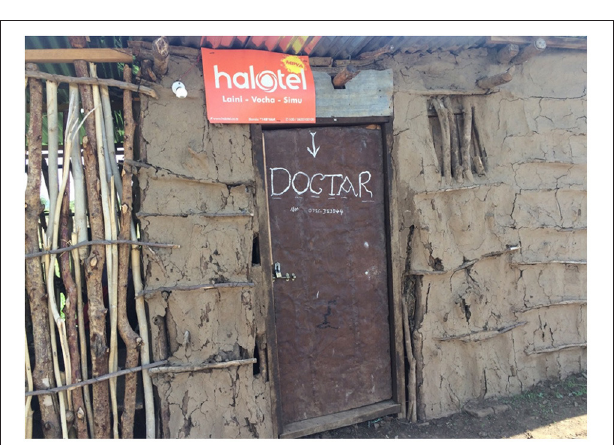
FIGURE 3 | A basic shop or “duka” in Naiti village where locals obtain most of their medicines.